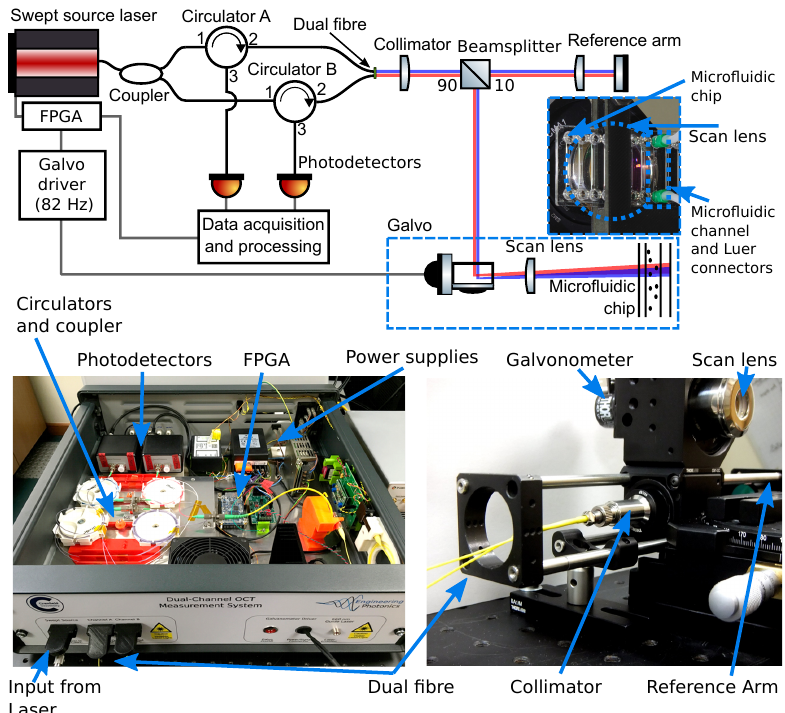
Figure 1. ( Top ) Schematic of the dual beam optical coherence tomography (OCT) instrument. Red and blue indicate the light from each of the single mode fibres contained within the dual optical fibre end propagating in free space (both beams are at the same wavelength). The beamsplitter uses 90% of the input light for the microfluidic chip and 10% for the shared reference arm of the interferometers. The microfluidic chip (containing 16 copies of the utilised microfluidic channel) through which the scan lens can be seen is pictured on the right. ( Bottom left ) Labelled picture of the custom-assembled instrument in a portable enclosure. ( Bottom right ) Labelled picture of the scan head without the microfluidic chip. Reproduced with permission from